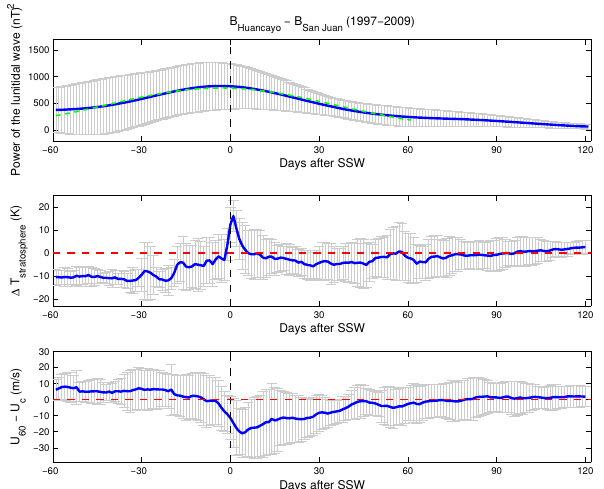
Figure 7. Results of the superposed epoch analysis: composite of the semi-monthly lunitidal wave power (top), zonal mean tempera- ture gradient (middle) and U 60 − U C (bottom) for the years 1997– 2009. The vertical dashed lines indicate the starting day of SSW events. The error bar represents the standard deviation in all the three panels. The dotted green curve in the top frame shows the Gaussian curve fitted for 60 days each on the either side of starting date of SSW